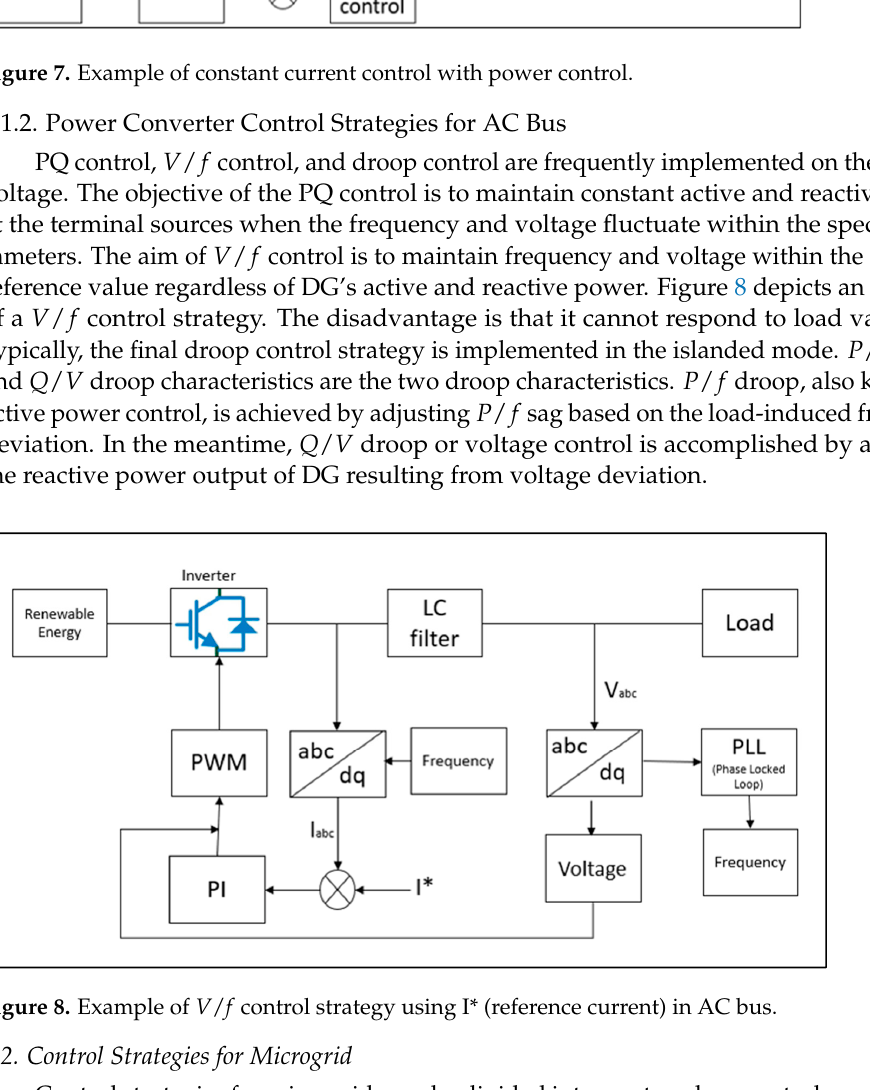
Figure 9. Sample architecture of master–slave control energy in microgrid.